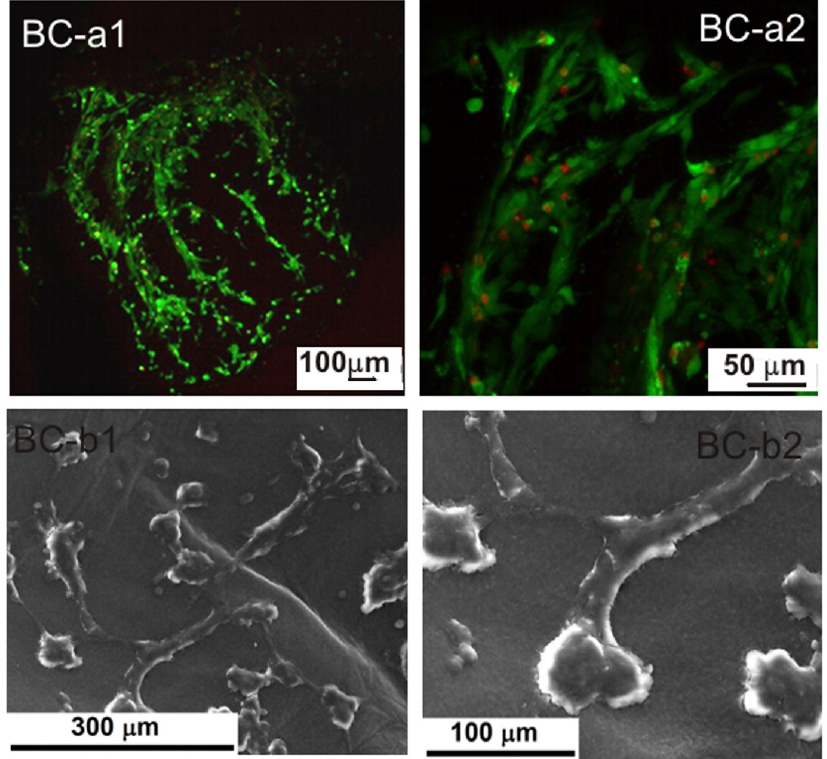
Figure 9. Fluorescence microscopy images ( a1 , a2 ) and SEM images ( b1 , b2 ) of the adherent cells on a